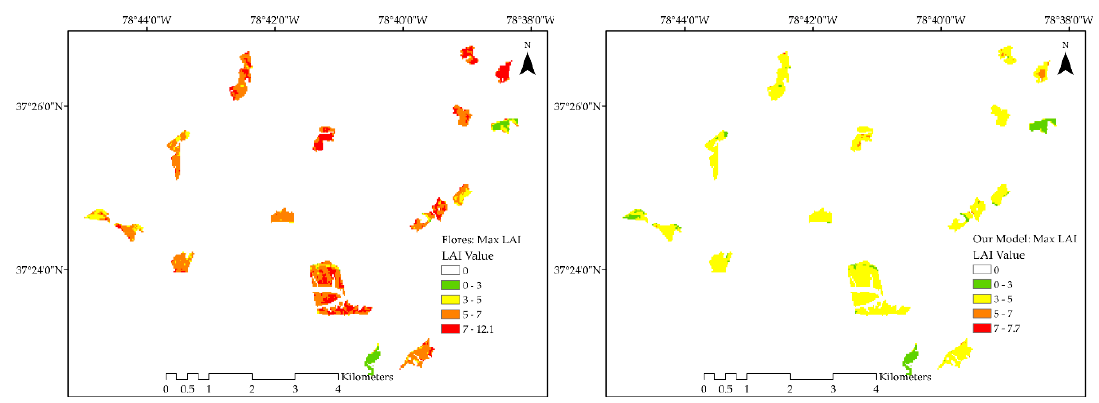
Figure 6. Minimum LAI shown for both the Flores et al. [15] model ( left ) and our combined model using SR ( right ).